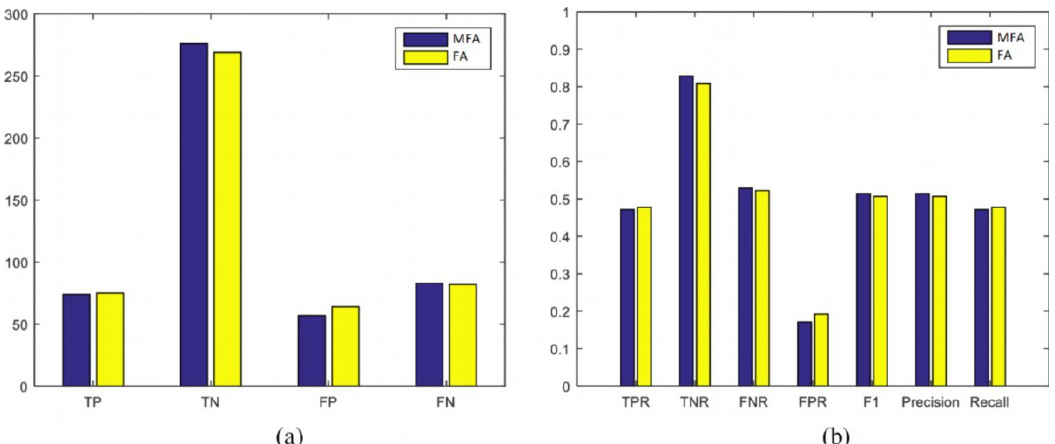
Figure 19. Scenario 4: Statistical evaluation of MFA-OSELM and FA-OSELM using two sets of measures, ( a , b ), for the TampereU dataset.